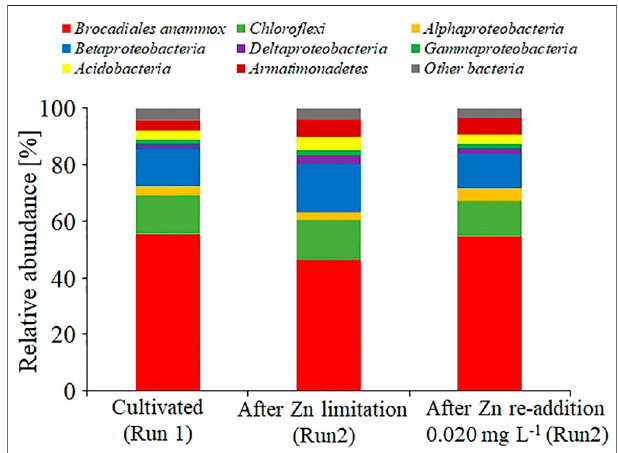
FIGURE 5 | Bacterial community structure in the gel carriers based on a meta 16S rRNA gene sequencing analysis. Results were obtained after cultivating without Zn(II) limitation (Run 1), after Zn(II) limitation (Run 2), and after adding 0.020 mg L − 1 of Zn(II) to the Zn(II)-limited